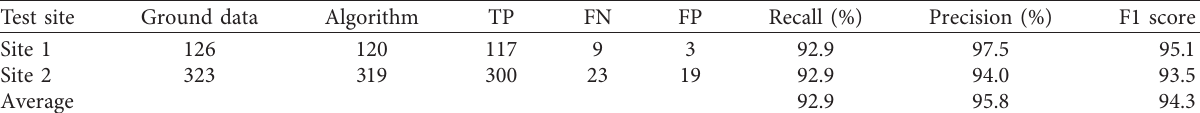
Figure 13: PLO detection results. (a) Site 1 (Rama IX Bridge). (b) Site 2 (Bang Na elevated expressway). All detected PLOs are displayed in red. Table 3: Quantitative evaluation of PLO detection at two test